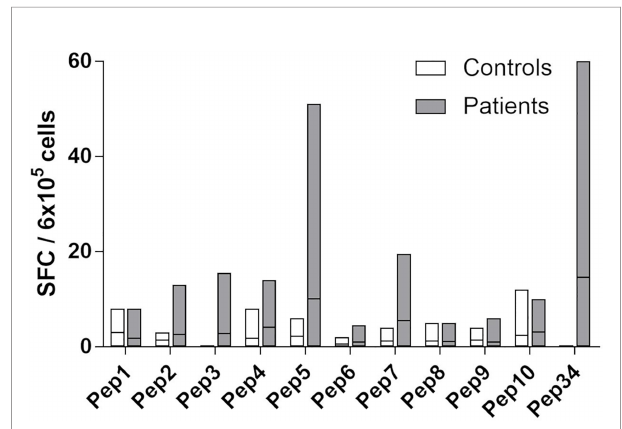
FIGURE 3 | Fine-mapping of T cell responses towards Pep34 (21OH 430-447 GEPLARLELFVVLTRLLQ). PBMCs from patients (n = 10) and controls (n =5) were stimulated ex vivo with individual overlapping 9-mer (Pep1-10) peptides covering Pep34, as well as Pep34 itself, and subjected to IFN g ELISPOT. Of note, Pep2 represents EPLARLELF. Results are expressed as IFN g SFCs per 6x10 5 PBMCs and lines represent median